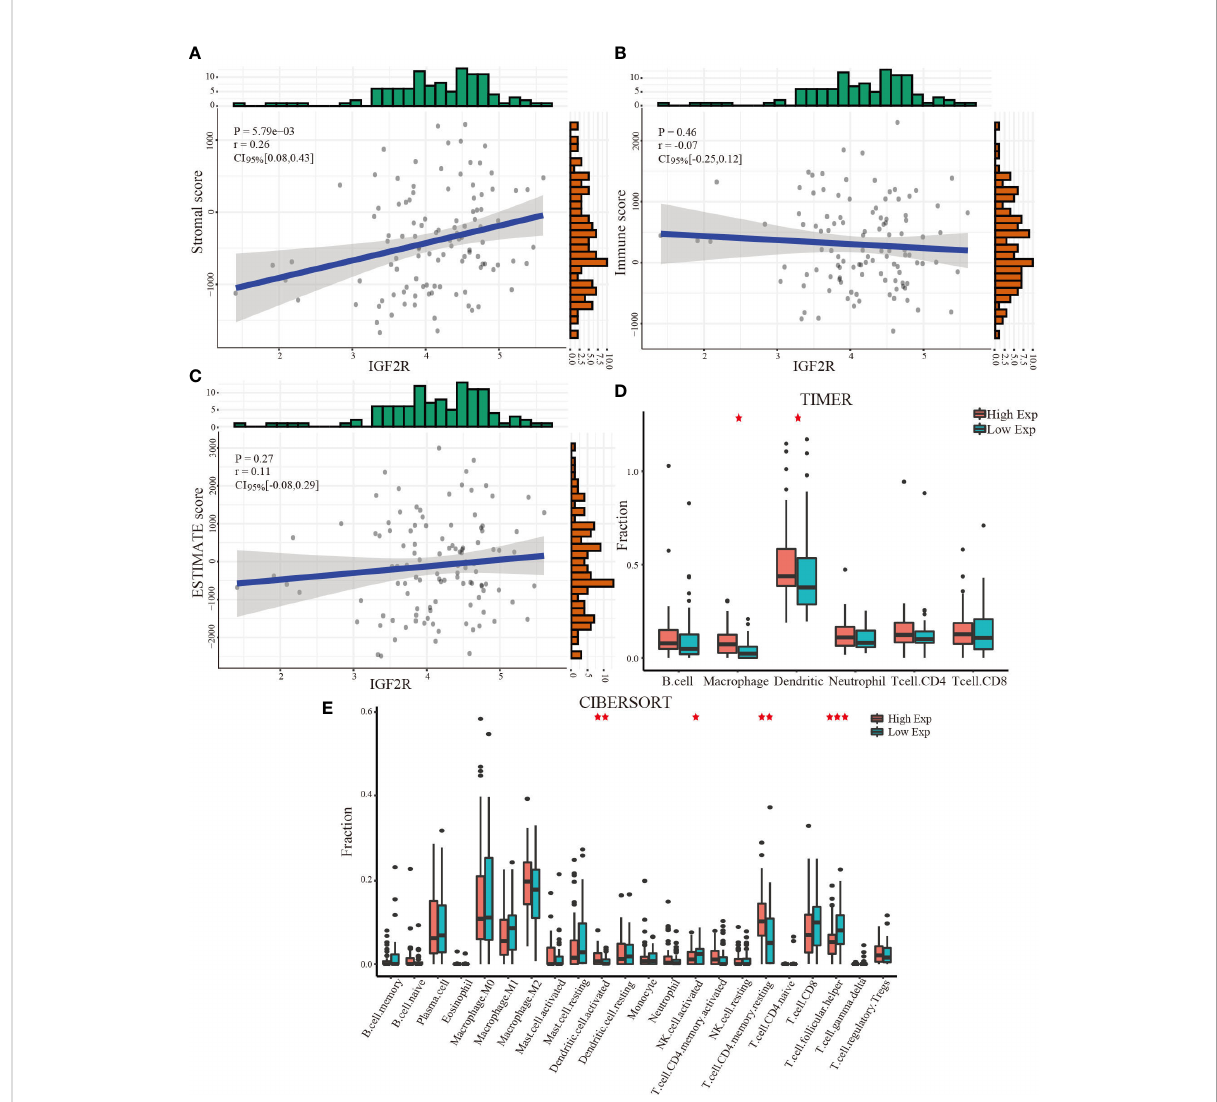
FIGURE 3 Relationship between IGF2R expression and the tumor microenvironment and immune cell in fi ltration. (A) IGF2R expression and the stromal score. (B) IGF2R expression and the immune score. (C) IGF2R expression and the ESTIMATE score. (D) Levels of six in fi ltrating immune cells across IGF2R expression as per TIMER. (E) Levels of 22 subtypes of in fi ltrating immune cells across IGF2R expression as per CIBERSORT. *,**,*** represent